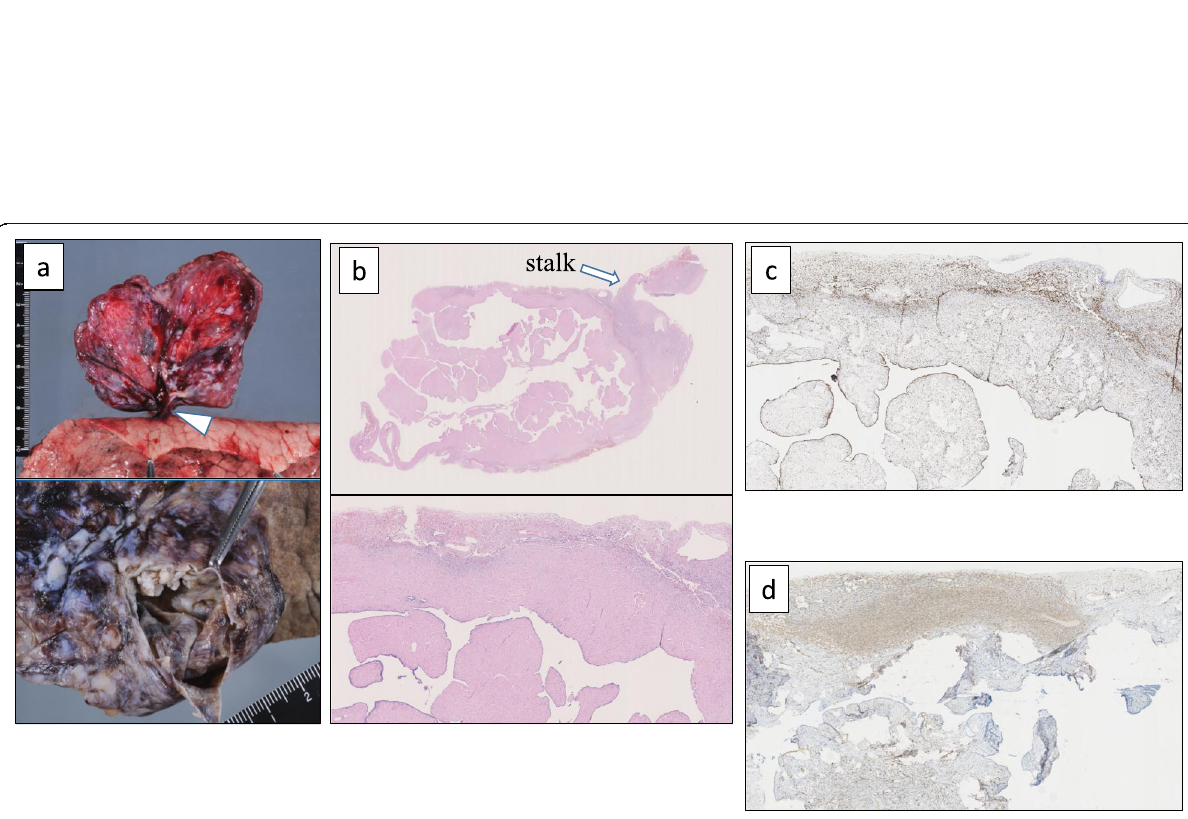
Fig. 4 The histopathological findings of the resected cystic tumor. A pedunculated cystic tumor was connected to the pleura with a stalk (white arrow head), and white polypoidal masses were found within the cystic tumor ( a ). Uniform fibroblastic spindle cell proliferation and marked cystic degeneration were found; all cyst walls were formed of the same tumor cells ( b ). Immunohistochemical staining revealed that the tumor cells were positive for STAT6, CD34 ( c , d